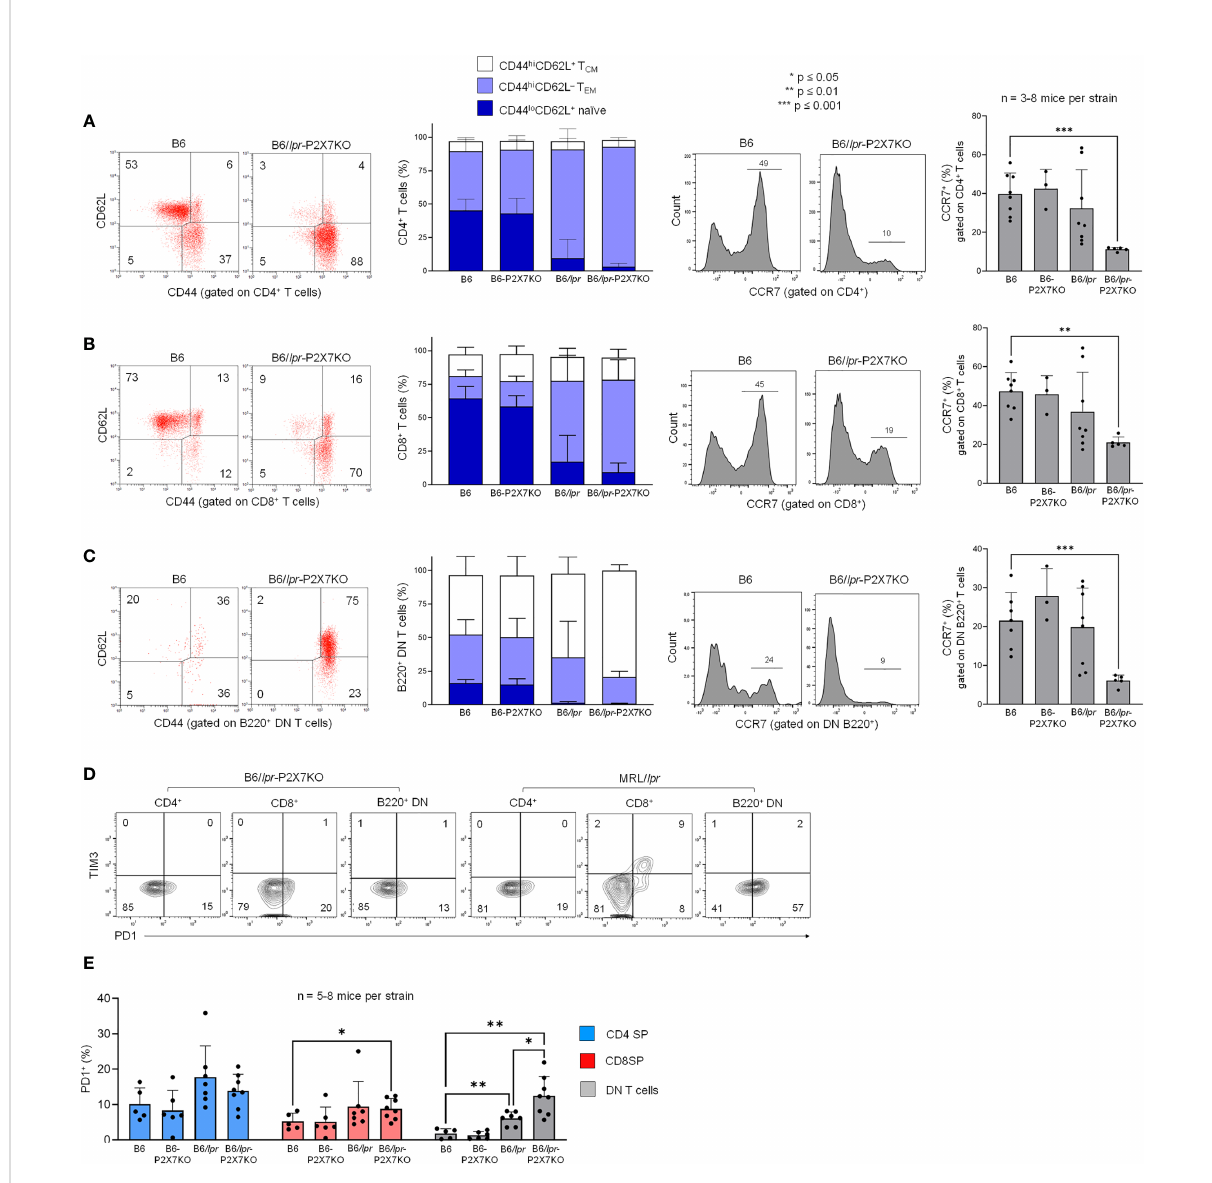
FIGURE 5 T cell subsets in B6 /lpr - p2x7 KO express predominantly central memory and effector memory phenotype but not PD-1 + Tim-3 + exhausted phenotype. Spleen cells from 7- to 8-month-old female wild-type B6, B6- p2x7 KO, B6/ lpr and B6/ lpr - p2x7 KO mice (A – E) and 4-month-old female MRL/ lpr mice (D) were stained with either fl uorescent mAbs against phenotypic markers CD90, B220, CD4, CD8 CD44, CD62L, CCR7, PD-1, Tim-3 or isotype controls and analyzed by fl ow cytometry. (A – C) Representative fl ow cytometry dot plots of CD44/CD62L staining. CD44 versus CD62L expression allowed to quantify the percentages of CD44 lo CD62L + naïve ( ), CD44 hi CD62L − effector memory ( , T EM ) and CD44 hi CD62L + central memory ( □ , T CM ) cells on gated CD4 SP (A) , CD8 SP (B) or B220 + DN (C) CD90 + T cells from each mouse strain. Stacked bar graphs ( A – C , second panel) show the respective proportions of naive, T EM and T CM cells in CD4 + , CD8 + and B220 + DN CD90 + T cells from each mouse strain. ( A – C , third panel) Representative fl ow cytometry histograms of CCR7 staining gated on CD4 SP (A) , CD8 SP (B) or B220 + DN (C) CD90 + T cells from each mouse strain. ( A – C , fourth panel) Bar graphs show the mean percentage (SD, n = 3-8 mice per strain) of CCR7-expressing CD4 SP, CD8 SP and B220 + DN CD90 + T cells from each mouse strain. (D) Quanti fi cation of PD-1 + Tim-3 + exhausted T cells by fl ow cytometry. Representative dot plots of PD-1/Tim-3 staining gated on CD4 SP, CD8 SP and B220 + DN CD90 + T cells. (E) Bar graphs show the mean percentage (SD, n = 5-8 mice per strain) of PD-1 + cells in gated CD4 SP ( ), CD8 SP ( ) or B220 + DN ( ) CD90 + T cells from each mouse strains. Each dot in the bar graphs represents an individual mouse. Error bars in graphs show SD. Asterisks above horizontal lines indicate statistically signi fi cant differences assessed with unpaired two-tailed t -test. *p ≤ 0.05, **p ≤ 0.01, ***p ≤